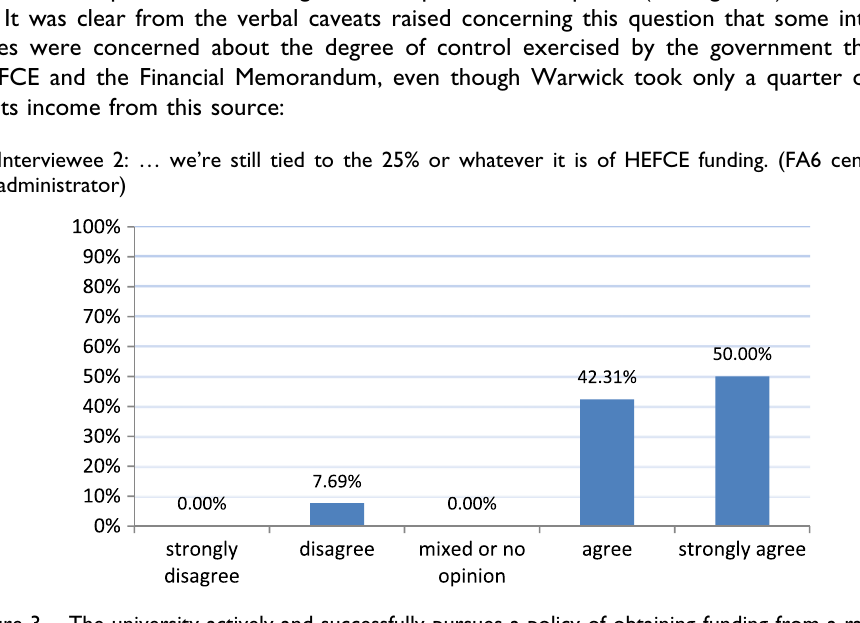
Figure 3. The university actively and successfully pursues a policy of obtaining funding from a range of sources so that is not reliant on any one particular